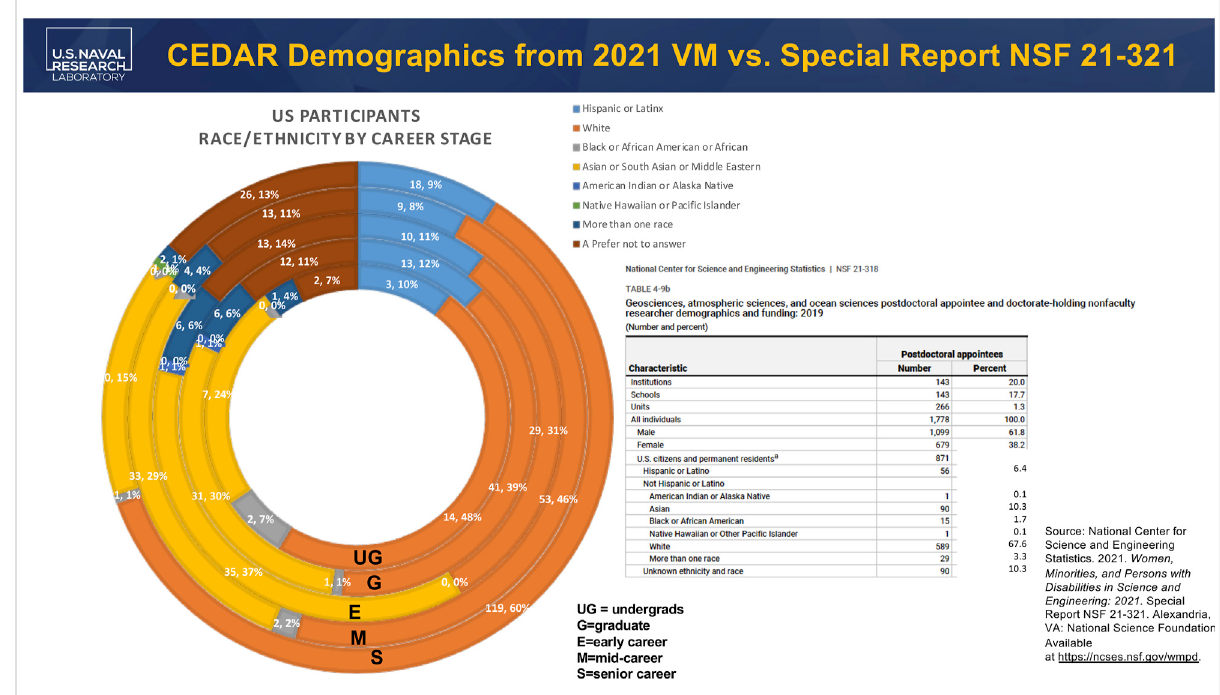
FIGURE 1 Example comparingrace/ethnicitydemographicsofUSParticipantsinthe2021 CEDARVirtualWorkshop